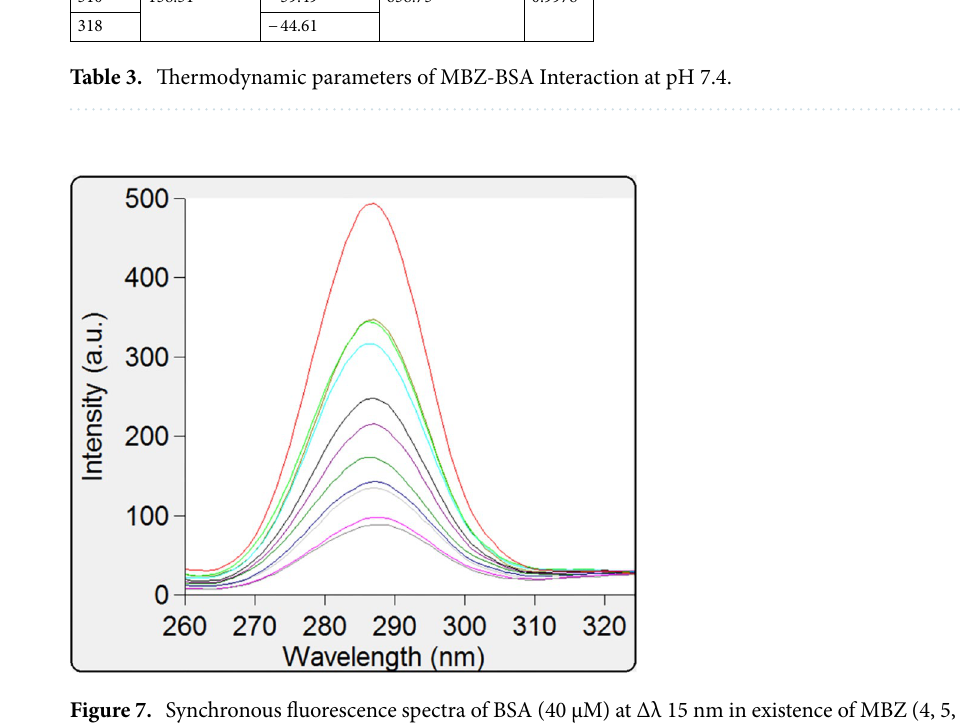
Figure 7. Synchronous fluorescence spectra of BSA (40 µM) at Δλ 15 nm in existence of MBZ (4, 5, 10, 15, 20, 25, 30, 35, 40, 45